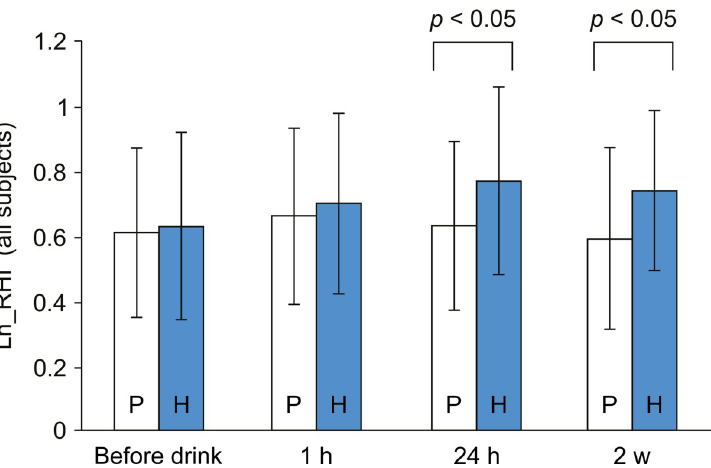
Fig 2. Ln_RHI values for all of the subjects. Results are presented as the height of the columns at each time point. P: the placebo group, H: the high H 2 group. Error bars are indicated on each column, and p -values are indicated above the compared columns between the two groups. RHI: reactive hyperemia index; H 2 :